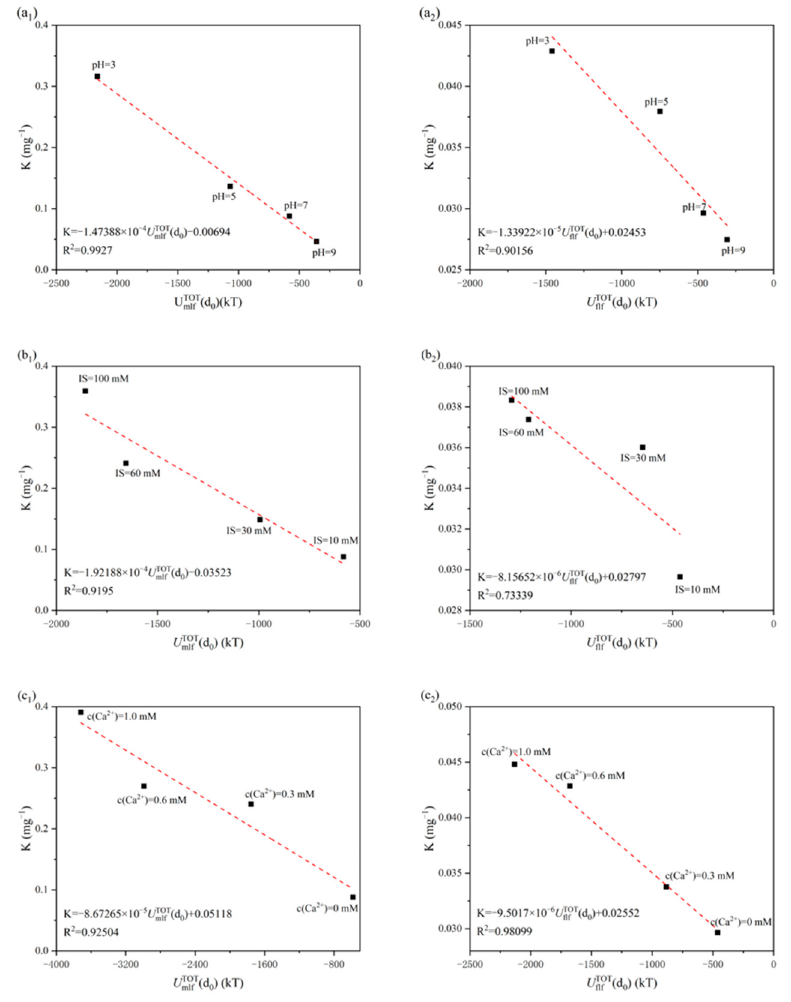
Figure 4. Correlation between fouling potential and interaction energy under different solution conditions: ( a 1 , a 2 ) pH, ( b 1 , b 2 ) ionic strength, and ( c 1 , c 2 ) calcium concentration. Subscript 1 represents initial fouling (adhesion) stage, subscript 2 represents later fouling (cohesion) stage.